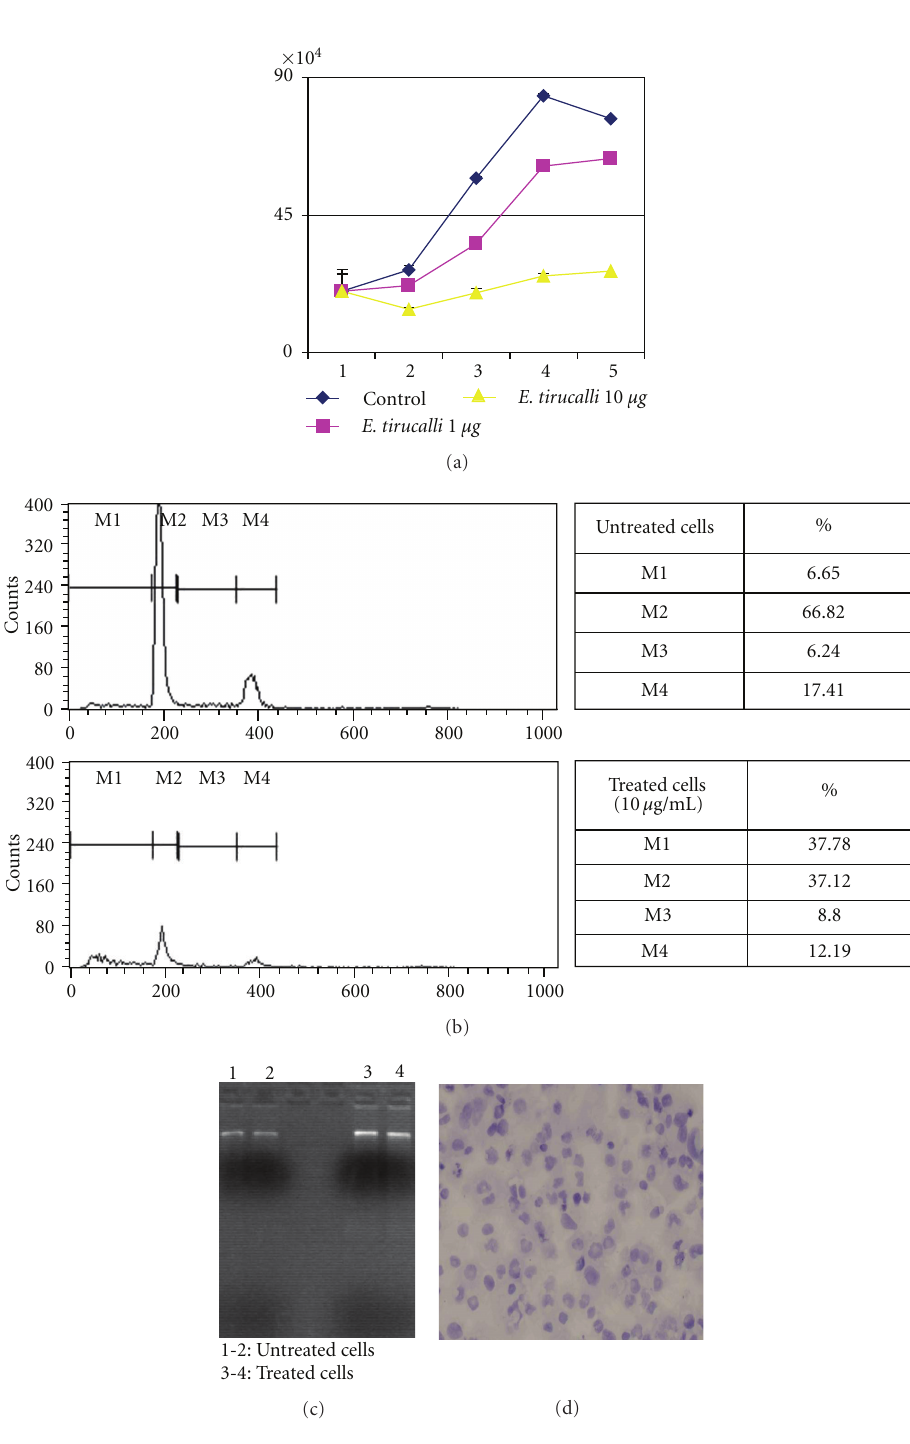
Figure 1: (a) Cord-blood-derived cells were treated with di ff erent concentration of E. tirucalli for five days, and proliferation has been monitored. Methanol-treated cells, with no E. tirucalli extract, have been used as a control. A dose-dependent decrease of proliferation rate is observed in E. tirucalli -treated cells ( P < 0 . 05). The graph is representative of three di ff erent experiments. Error bars represent standard deviation between duplicates. (b) Cell cycle analysis by FACS on untreated (upper part) and E. tirucalli -treated cells (lower part). Tables indicate the percentage of cells in each cell cycle stages, where M1 indicates total number of dead cells (apoptotic and necrotic cells), M2 indicates G0/G1, M3 cells in S phase, and M4 the G2/M phase. Treated cells show a higher number of the M1 fraction. (c) Electrophoresis on agarose gel of untreated (lanes 1-2) and E. tirucalli -treated cells (lanes 3-4). No DNA laddering indicative of cell death by apoptosis is visible. (d) ICC for caspase 3. No caspase activation is detected following E. tirucalli